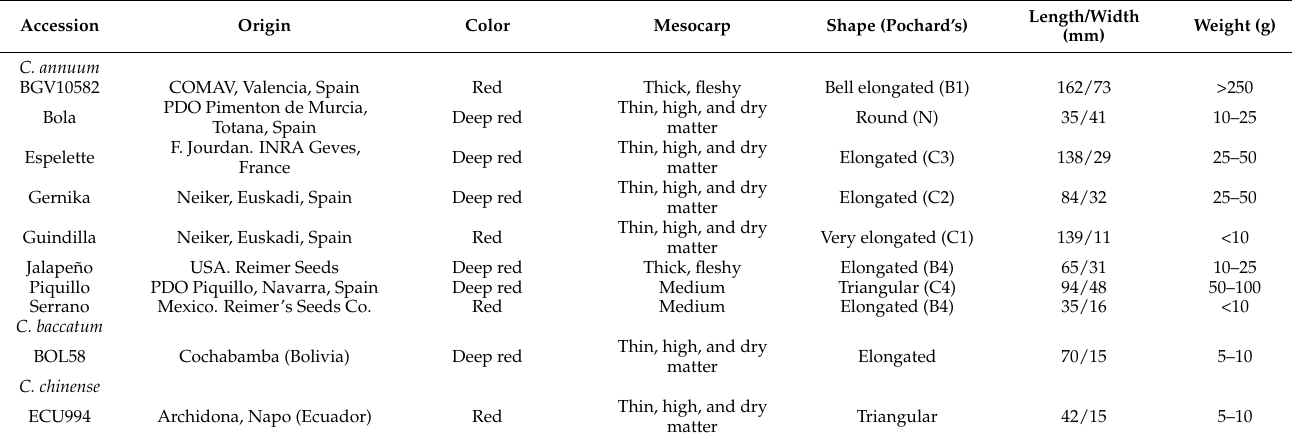
Table 3. List of accessions used, including their local name, origin, and some relevant fruit